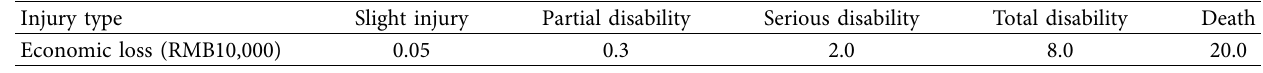
Table 4: Statistical analysis of mean economic loss of one person/time in an